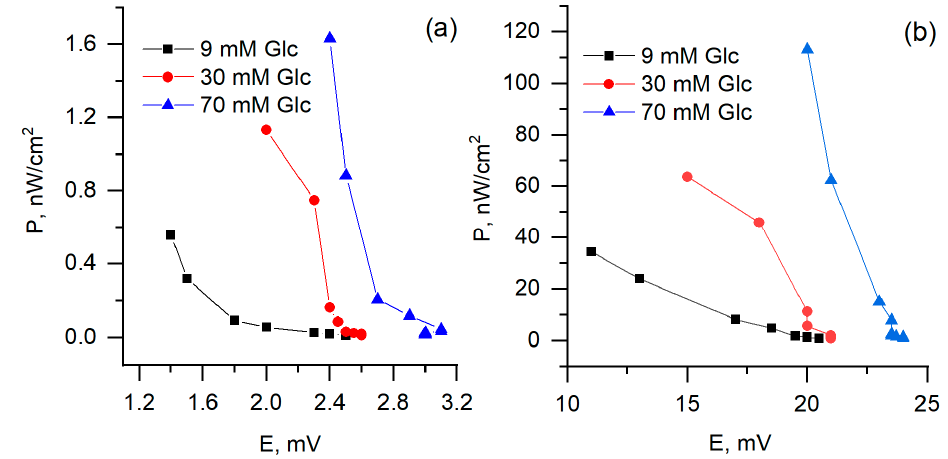
Figure 12. Generated power dependence on potential, ( a ) PQ- and ( b ) PQ/MW-CNT-modified graphite electrode as an anode.